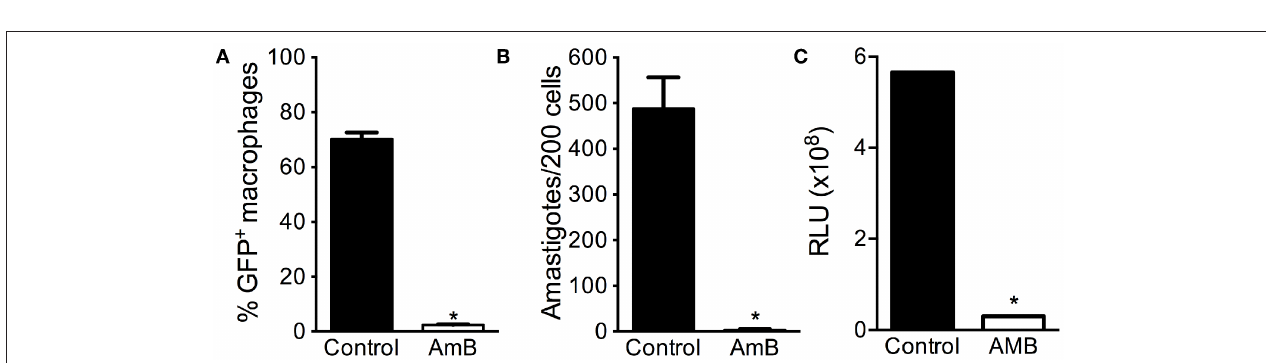
FIGURE 6 | Applicability of eGFP-LUC L. braziliensis for drug screening. Bone-marrow derived macrophages were infected with either WT or eGFP-LUC L. braziliensis (clone #7), for 24h. Cells were treated with Amphotericin B and assayed by flow cytomery to determine (A) the percentage of infected cells. Infected cells were also stained with H&E and the number of amastigotes per 200 macrophages was determined by optical microscopy (B) . Luminescence intensity of eGFP-LUC Lb -infected macrophages was measured using a microplate reader, after addition of luciferin (C) . RLU, relative light units. Data (mean ± SEM) are from three experiments experiment, each performed in triplicate. * indicates statistically significant